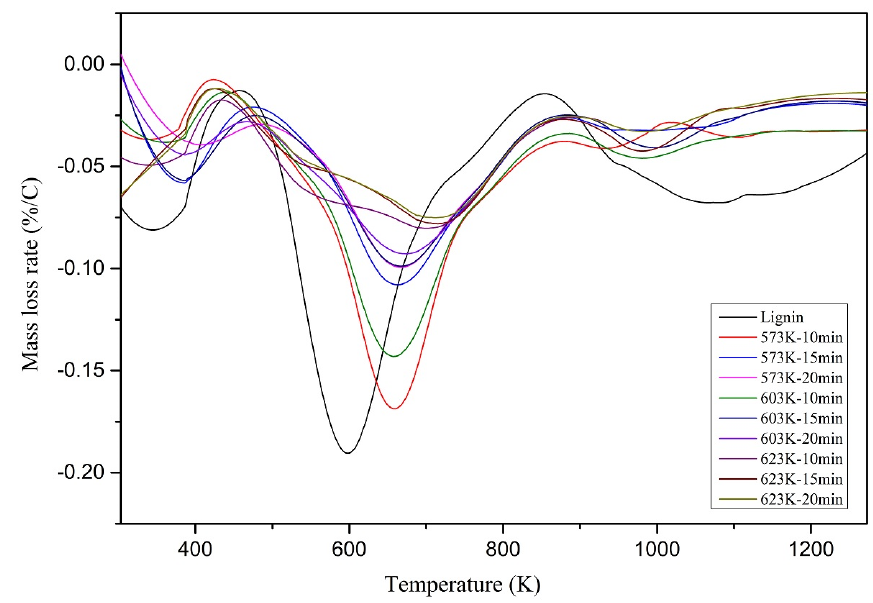
Figure 7. DTG curves of lignin and the chars at 20 C/min under N2.